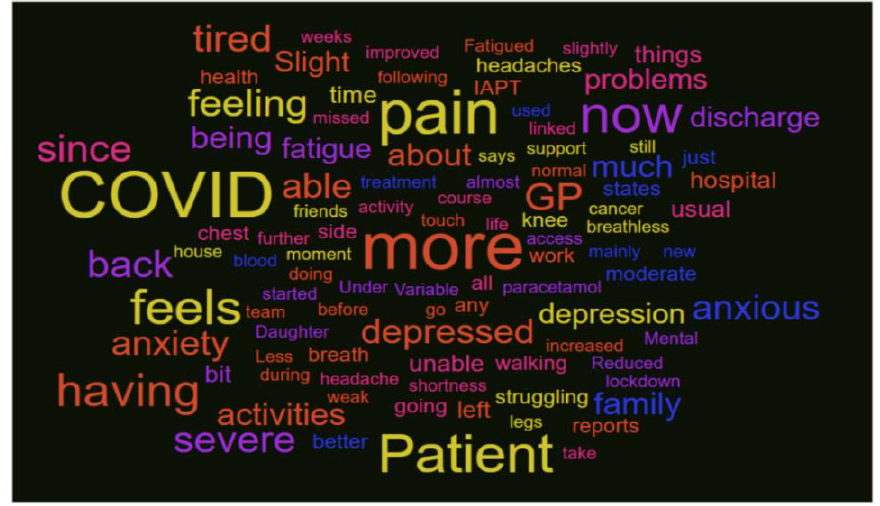
Figure 3. Wordle image combining analysis of triage information reporting primary symptoms.